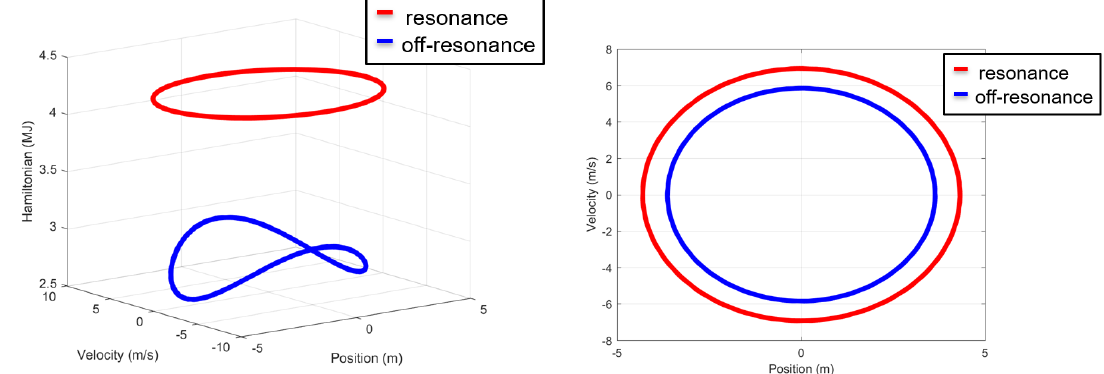
Figure 5. For a single frequency the resonance ω = Ω and off-limit cycle ω (cid:54) = Ω comparisons, 3d ( left ) and phase-plane ( right )